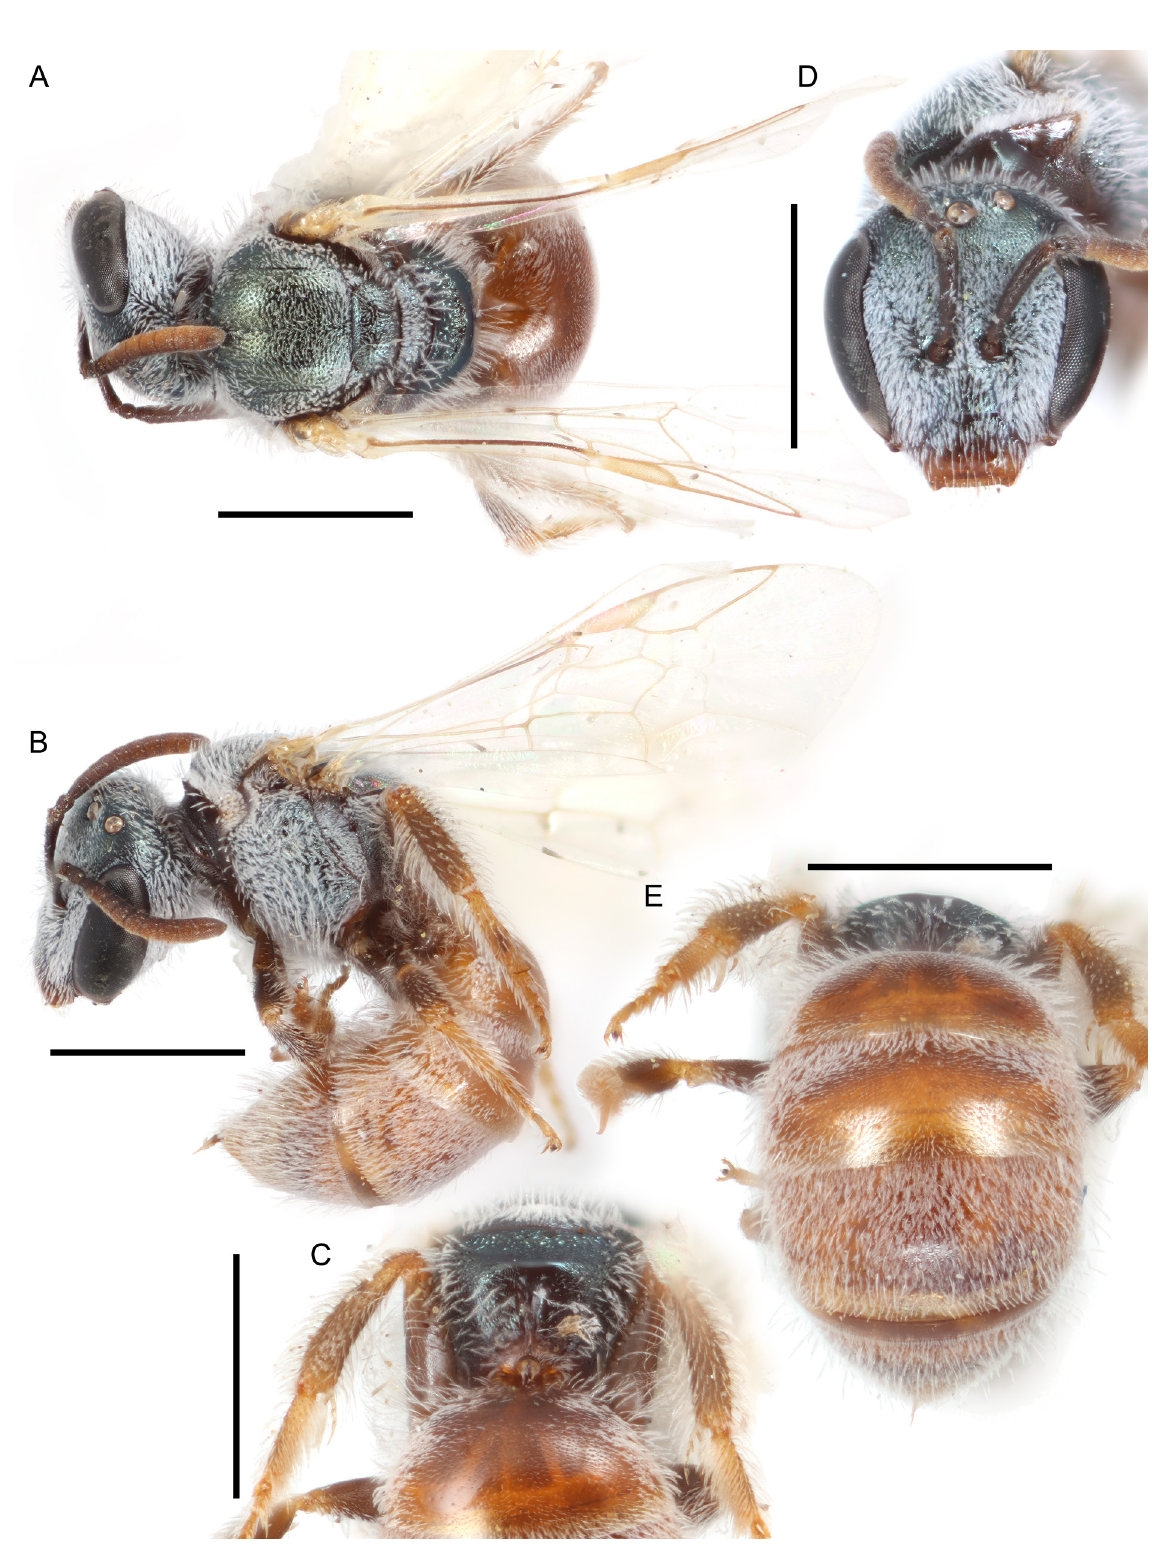
Fig. 11. Lasioglossum ( D. ) argammon sp. nov., holotype, ♀. A . Dorsal habitus. B . Lateral habitus. C . Propodeum. D . Face. E . Metasoma. Scale bars: 1